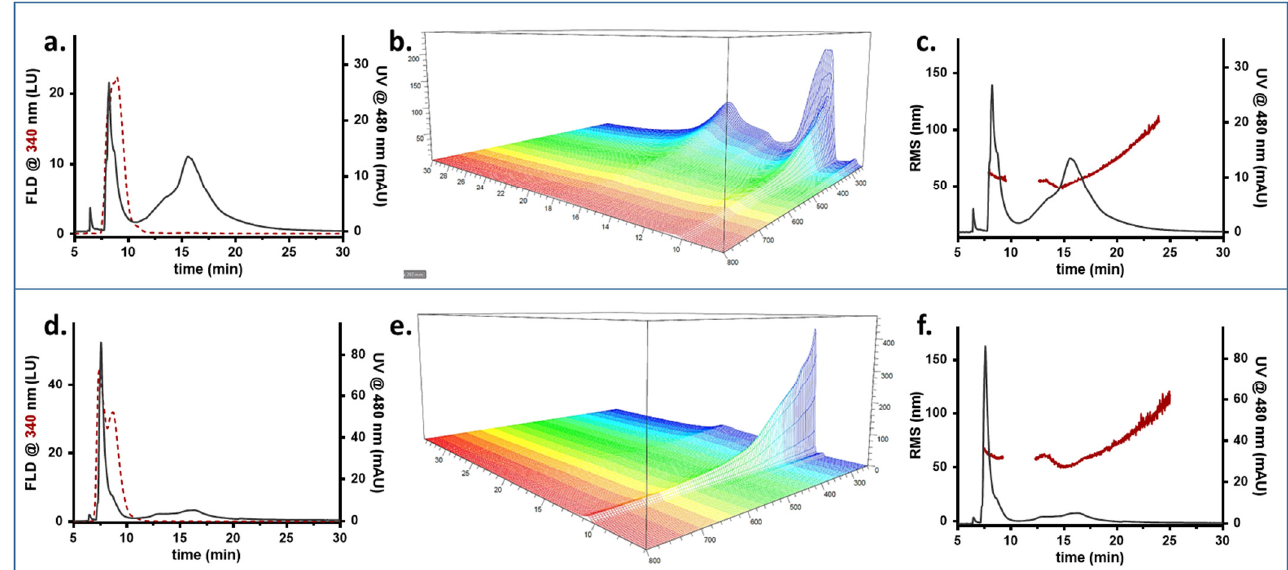
Figure 6. FFF fractogram (red dashed line: fluorescence signal; grey line: absorption signal), UV-Vis absorption spectrum, and Molar Mass/RMS radius (red) and fluorescence/UV profile (grey) obtained for 1:2 PP-MNP:HSA ( a – c ) and 1:4 PP-MNP:HSA ( d – f ) suspensions.